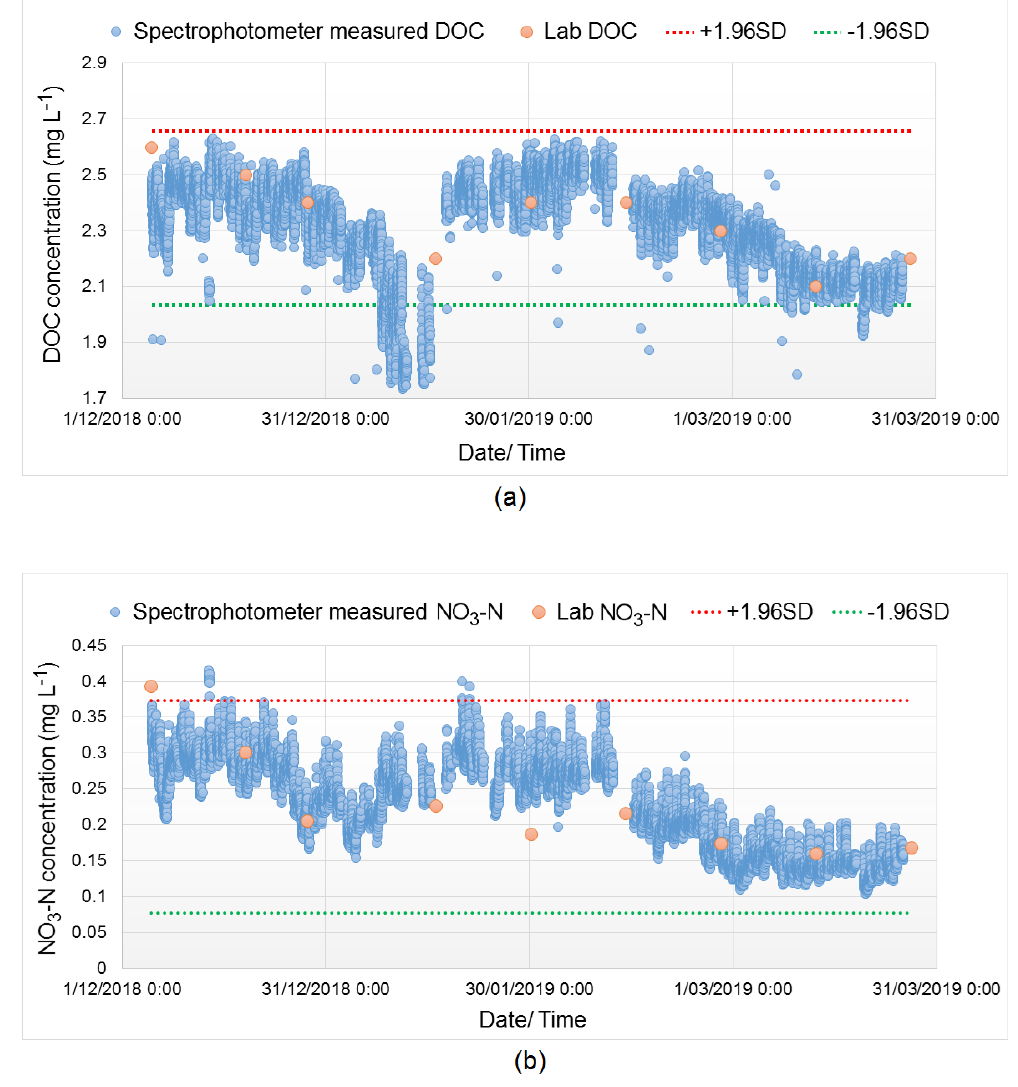
Figure 7. Calibration of the spectrophotometer using lab data for ( a ) DOC measurement and ( b ) NO 3 -N measurement (red and green dotted line indicate the 95% confidence interval for the upper and lower limit).